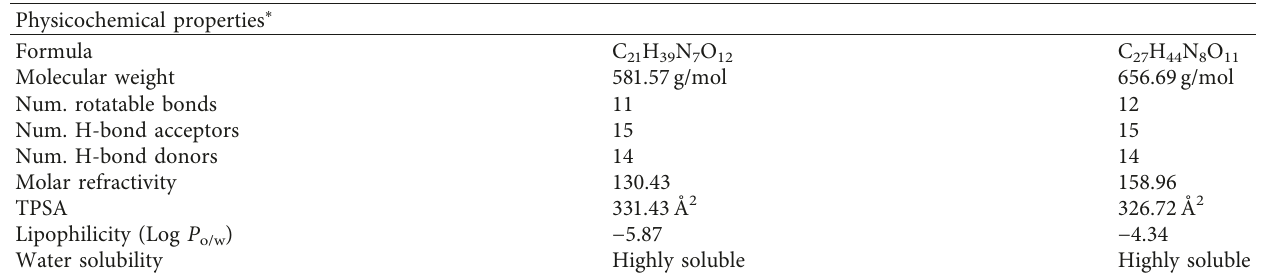
Table 6: Results of physicochemical properties obtained from SwissADME web